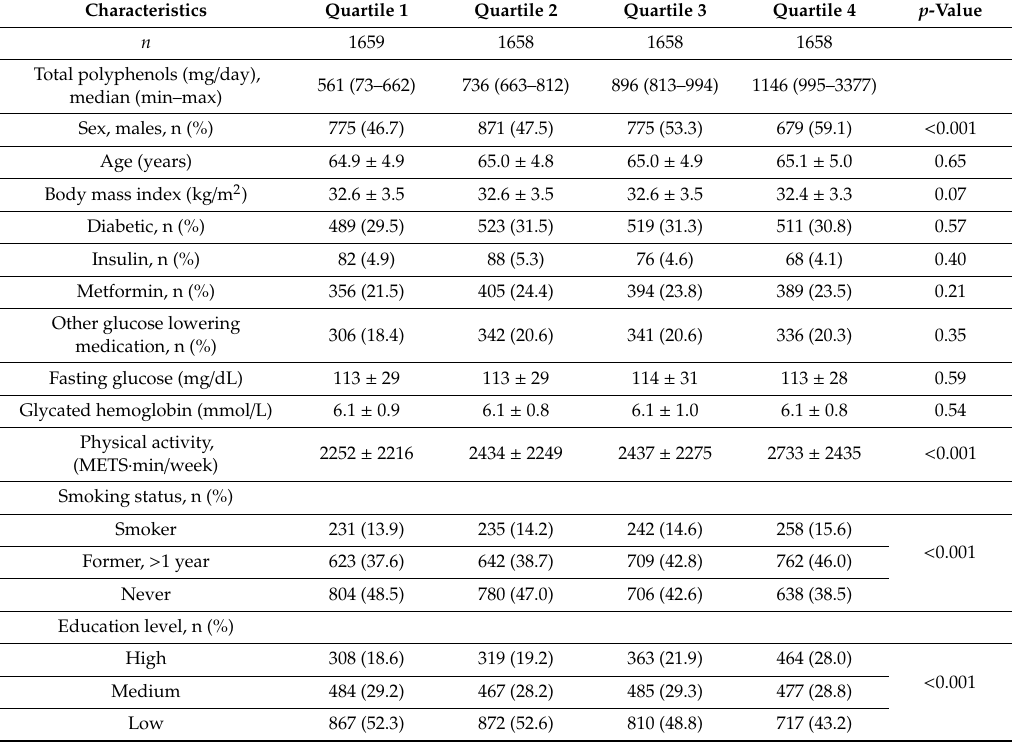
Table 1. Baseline characteristics by quartiles of energy-adjusted polyphenol intake ( n = 6633).